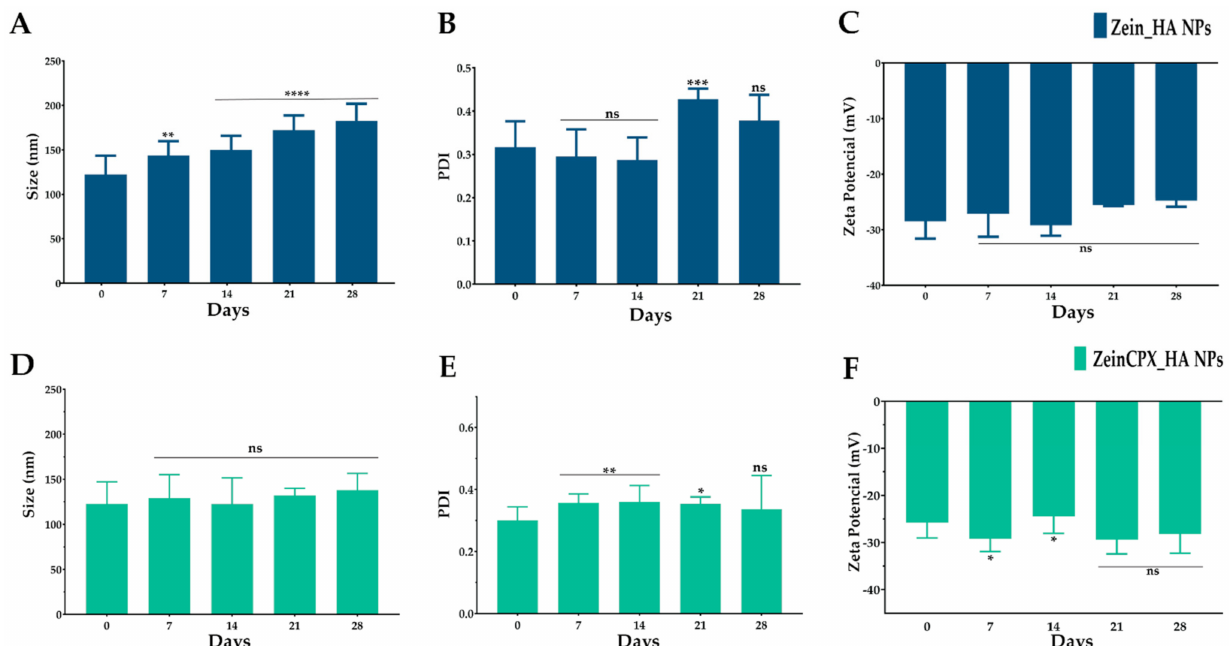
Figure 5. Stability of Zein_HA NPs ( A – C ) and ZeinCPX_HA NPs ( D – F ), after lyophilization, for 28 days. Data are presented as mean ± standard deviation, n = 5, ns p > 0.05, * < p = 0.05, ** < p = 0.01, *** p < 0.001, ****< p = 0.0001, values marked with asterisks are statistically different from Day